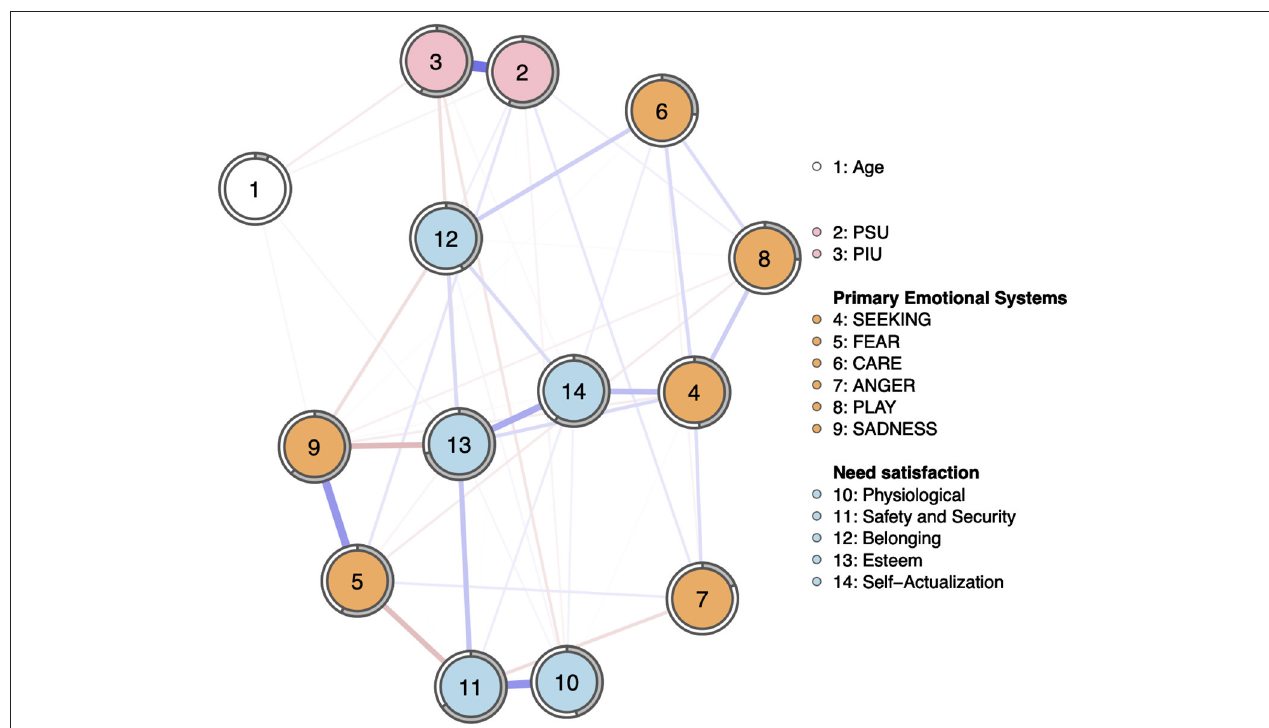
FIGURE 1 | Regularized partial correlation network (tuning-parameter gamma = 0.5). Blue edges represent positive, red edges represent negative regularized partial-correlations. Thickness of line indicates strength of relationship. The values of edges are in Supplementary Table 2 . The gray “pie” chart surrounding each node depicts the proportion of a given node’s variance explained by other nodes in the